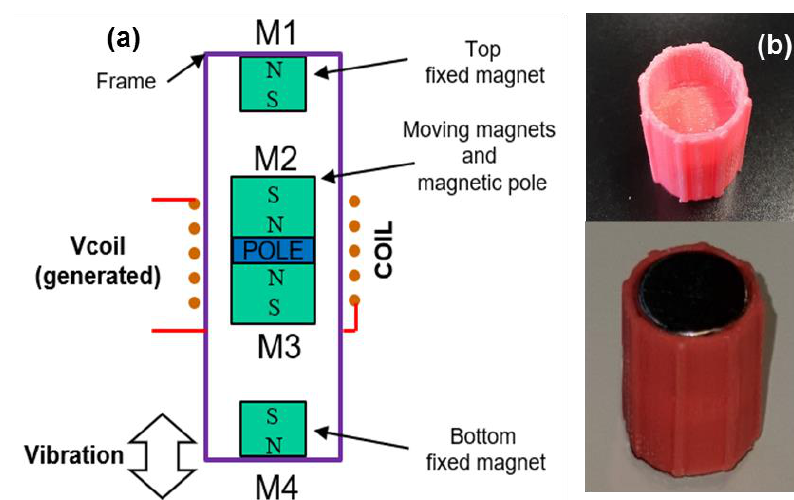
Figure 1. Harvester, ( a ) schematic diagram and ( b ) PLA part and final inertial mass with magnets.